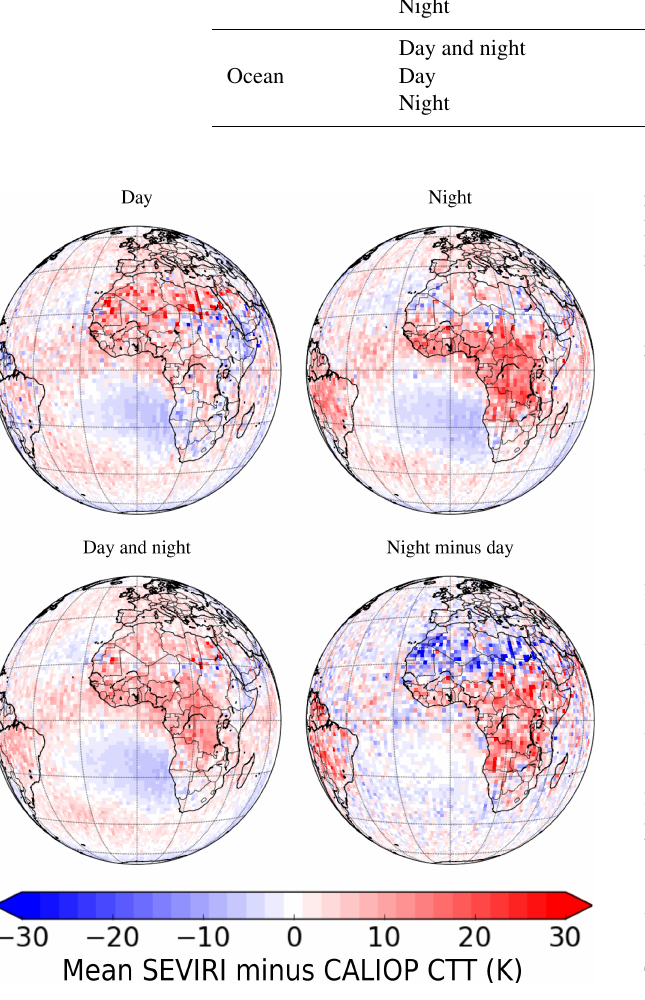
Figure 6. Spatial distribution of the bias in SEVIRI cloud top temperature retrievals during 2007. Biases are shown for the day (13:30LST CALIOP overpass), night (01:30LST CALIOP over- pass), mean of both day and night biases, and difference (night mi- nus day) between night- and daytime